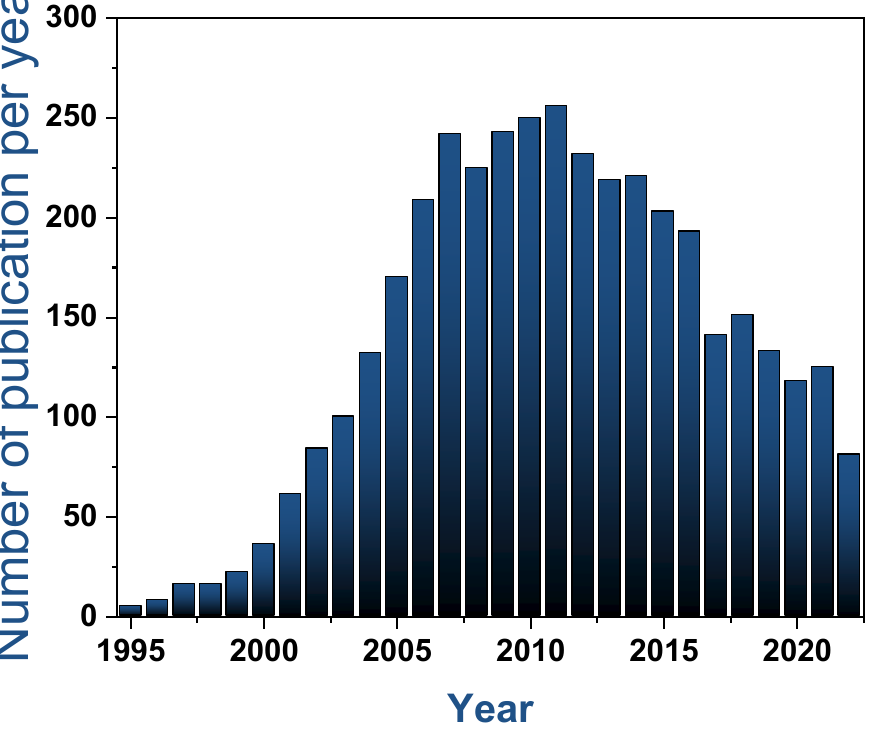
Figure 1. The number of articles published on porous anodic alumina. Source: Web of science. The search was carried out in November 2022.